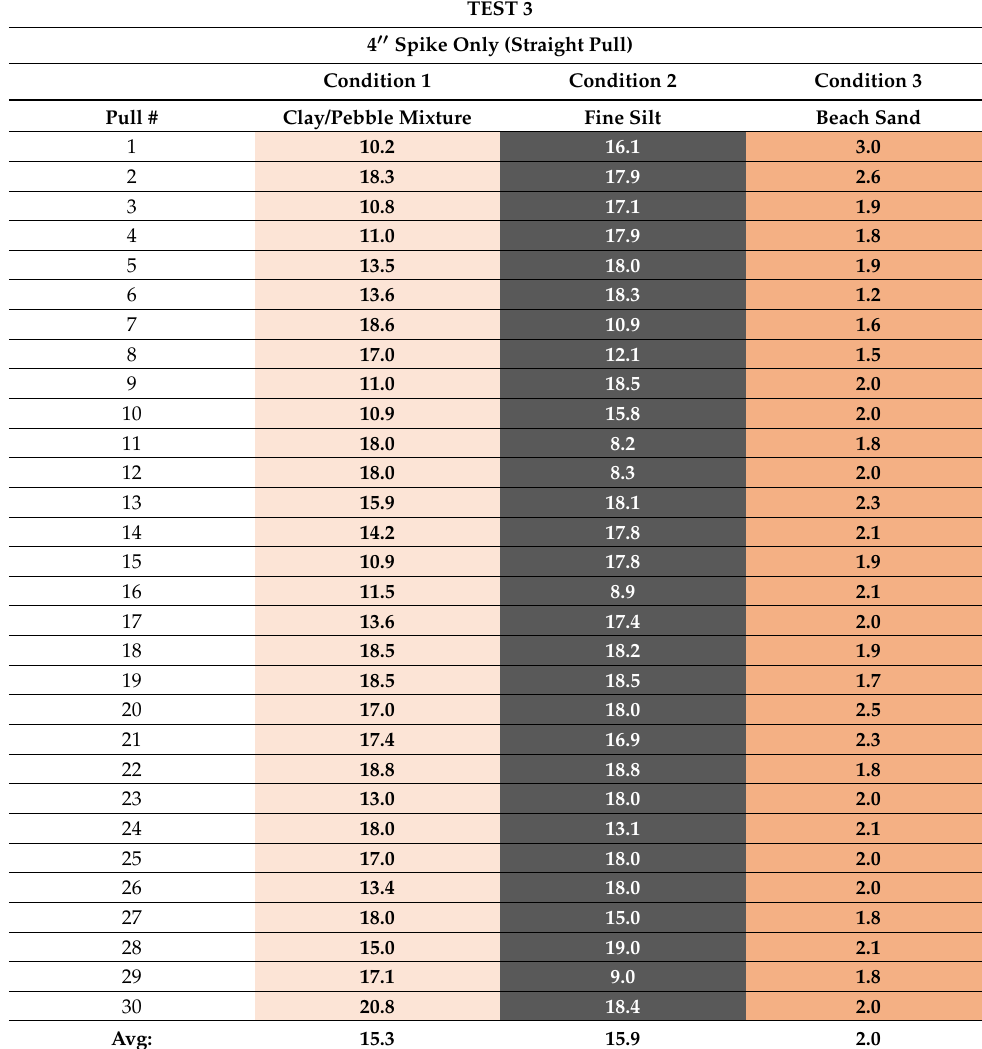
Table A3. Test 3: complete anchoring failure tension data (lbf).